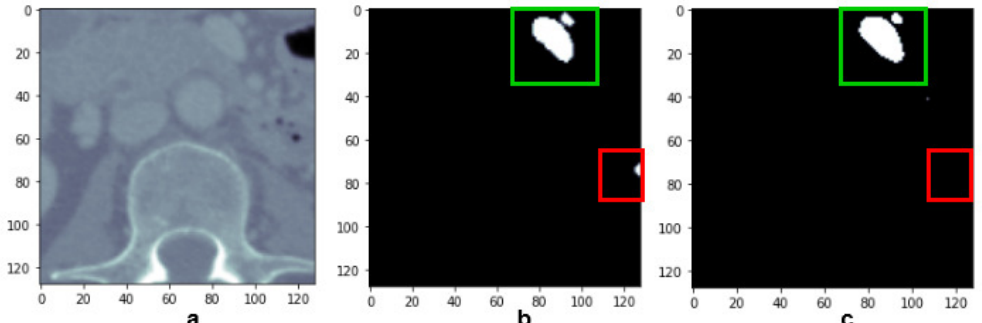
Figure 13. Portal vein sample 6: image ( a ), original mask ( b ) and predicted mask ( c ) after pre- processing with zoom.